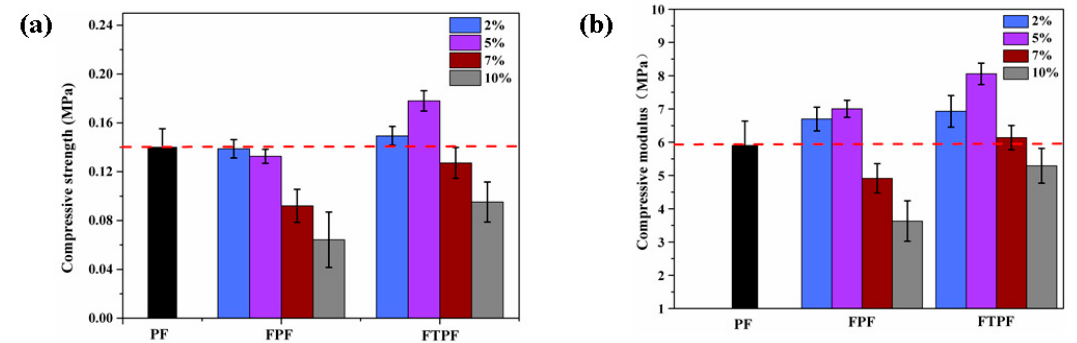
Figure 4. Normalized ( a ) compressive strength and ( b ) compressive modulus of PF, FPFs, and FTPFs.